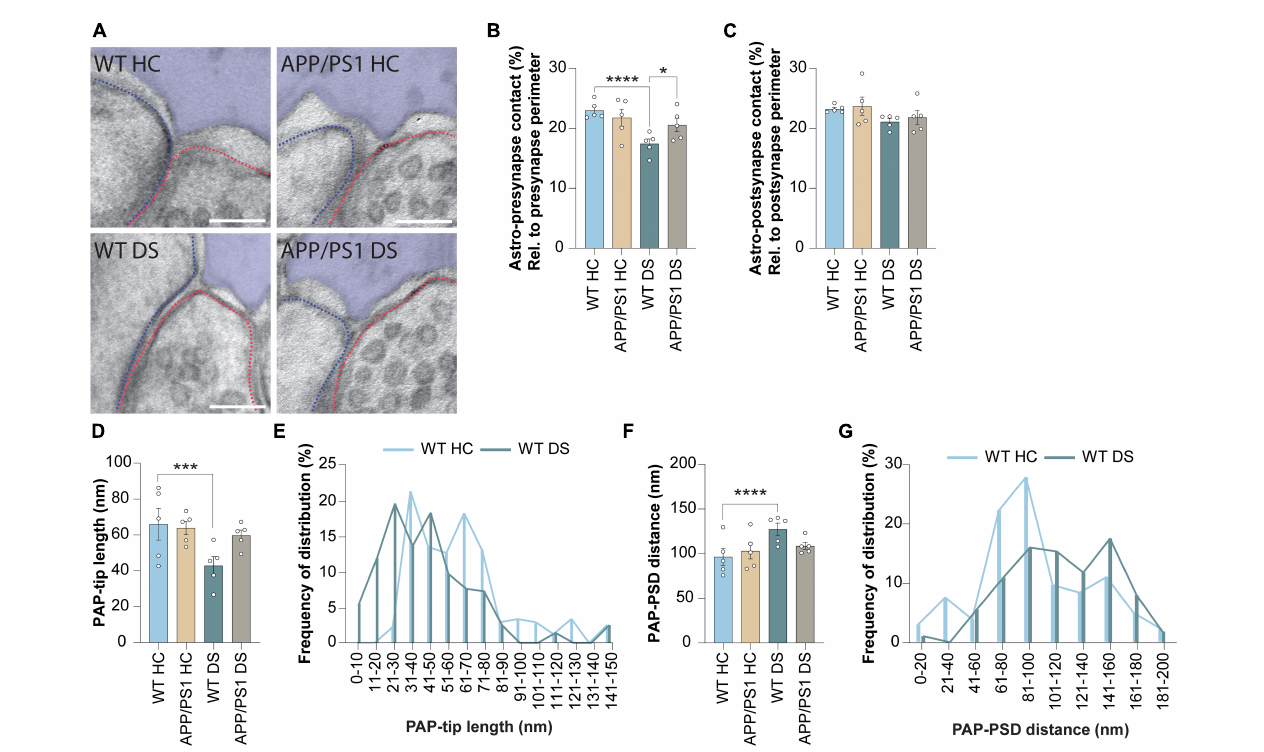
FIGURE3 Contextual fear conditioning causes PAP retraction after 4 h in WT but not in APP/PS1 mice. (A) Representative images showing WT home cage (HC), APP/PS1 HC, WT delayed shock (DS) and APP/PS1 DS conditions. Astrocyte is pseudo-colored in purple. Outline of the pre-synapse is indicated with the red dashed line, the outline of the post-synapse is indicated by the blue dashed line. Scale bar, 100 nm. (B) Shared contact between the astrocyte (Astro) and pre-synapse, relative (rel.) to the pre-synapse perimeter and expressed as percentages (%). (C) Shared contact between the astrocyte and post-synapse, relative to the post-synapse perimeter and expressed as percentages. (D) Quantification of the length of the PAP tip protruding toward the synaptic cleft. (E) Frequency distribution plots of WT HC and WT DS conditions of the data presented in panel (D) . (F) Quantification of the distance between the PAP-tip and PSD. (G) Frequency distribution plots of WT HC and WT DS conditions of the data presented in panel (F) . Data is presented as mean ± SEM. * P ≤ 0.05; *** P ≤ 0.001; **** P ≤ 0.0001. (B) WT HC n = 5/158, APP/PS1 HC n = 5/108, WT DS n = 5/164, APP/PS1 DS n = 5/156; c: WT HC n = 5/168, APP/PS1 HC n = 5/107, WT DS n = 5/173, APP/PS1 DS n = 5/169; d + f; WT HC n = 5/104, APP/PS1 HC n = 5/67, WT DS n = 5/94, APP/PS1 DS n = 5/98. Statistical details are reported in Supplementary Table 1